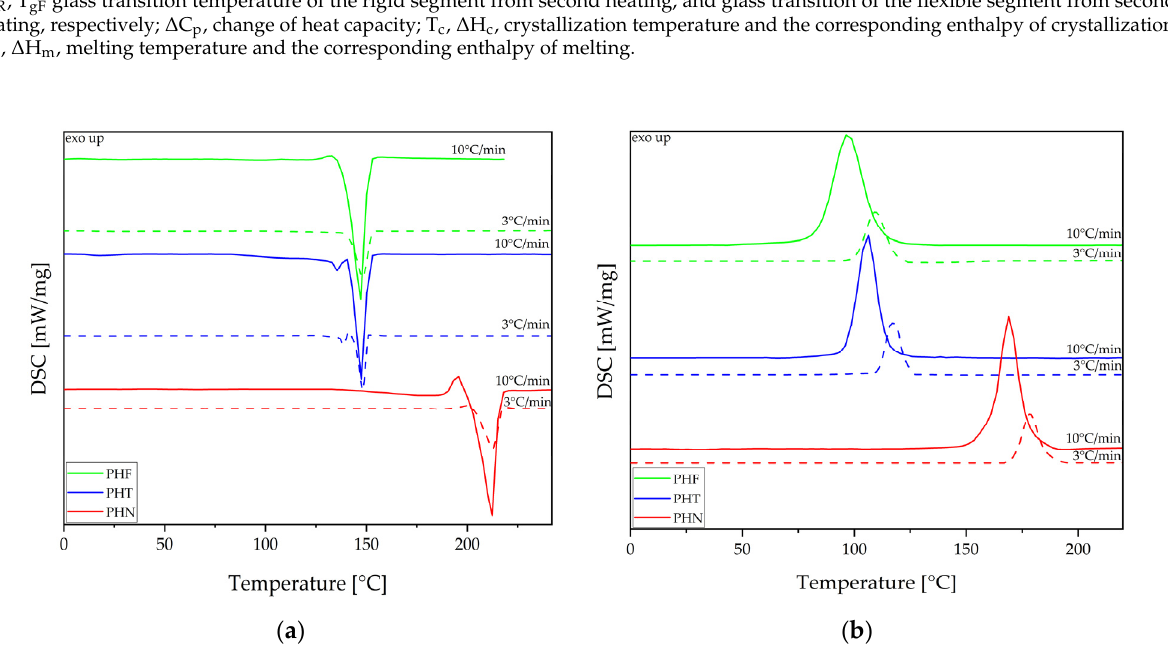
Figure 8. Differential scanning calorimetry (DSC) thermograms were recorded during the second heating ( a ) and cooling ( b ) of